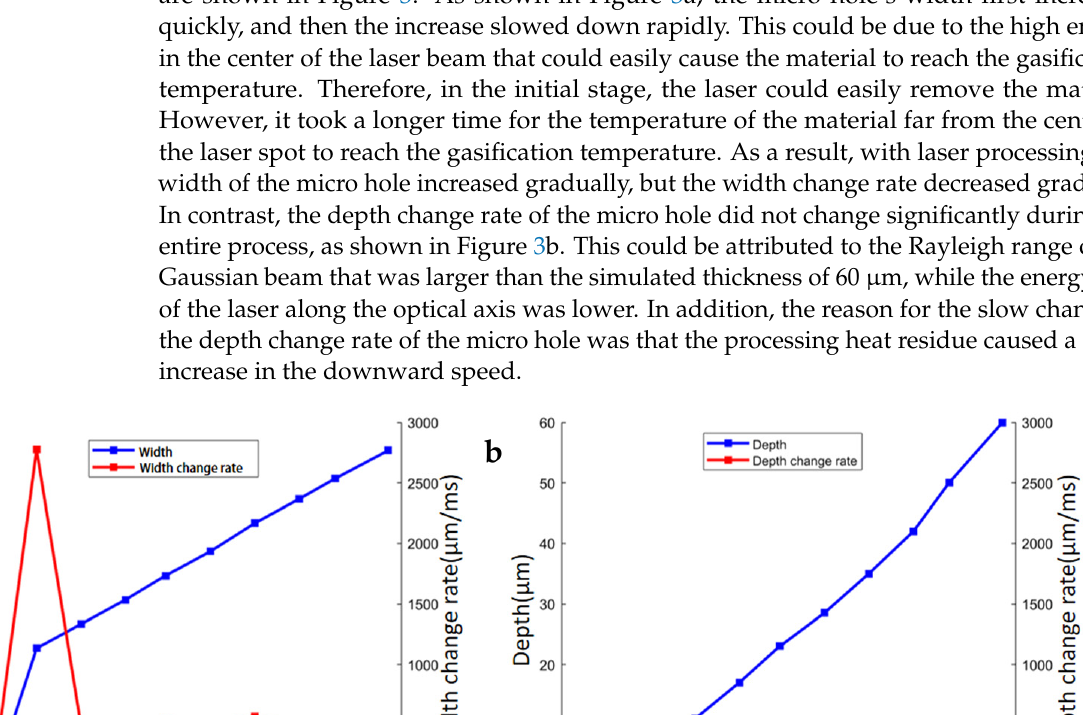
Figure 2. Phase transition process of the free interface of the titanium alloy micro hole with the laser processing time t . ( a ) t = 0.058755 ms; ( b ) t = 0.11994 ms; ( c ) t = 0.16412 ms; ( d ) t = 0.23016 ms.